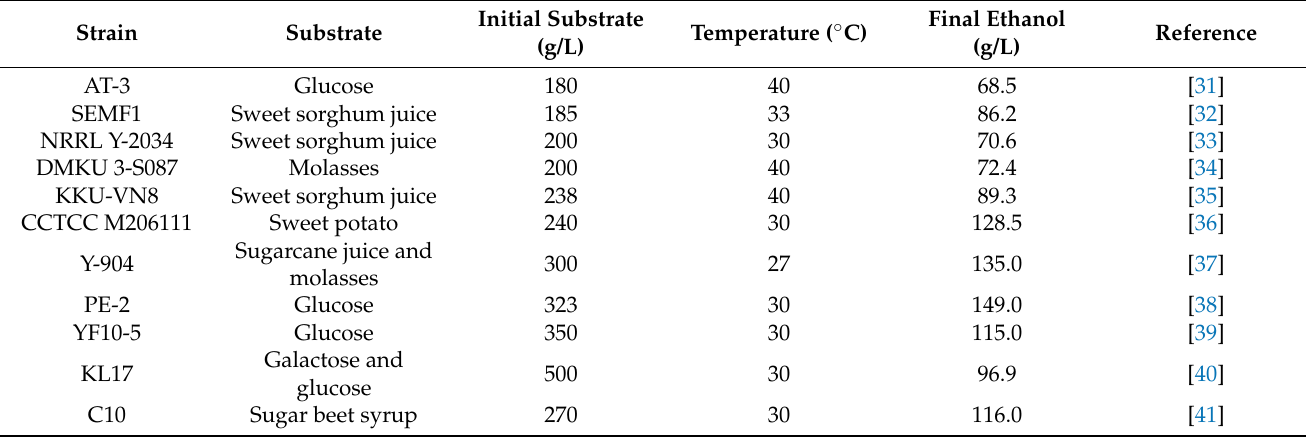
Table 1. Comparative performance in the production of bioethanol by different strains of S. cerevisiae using different substrates, initial concentration, and